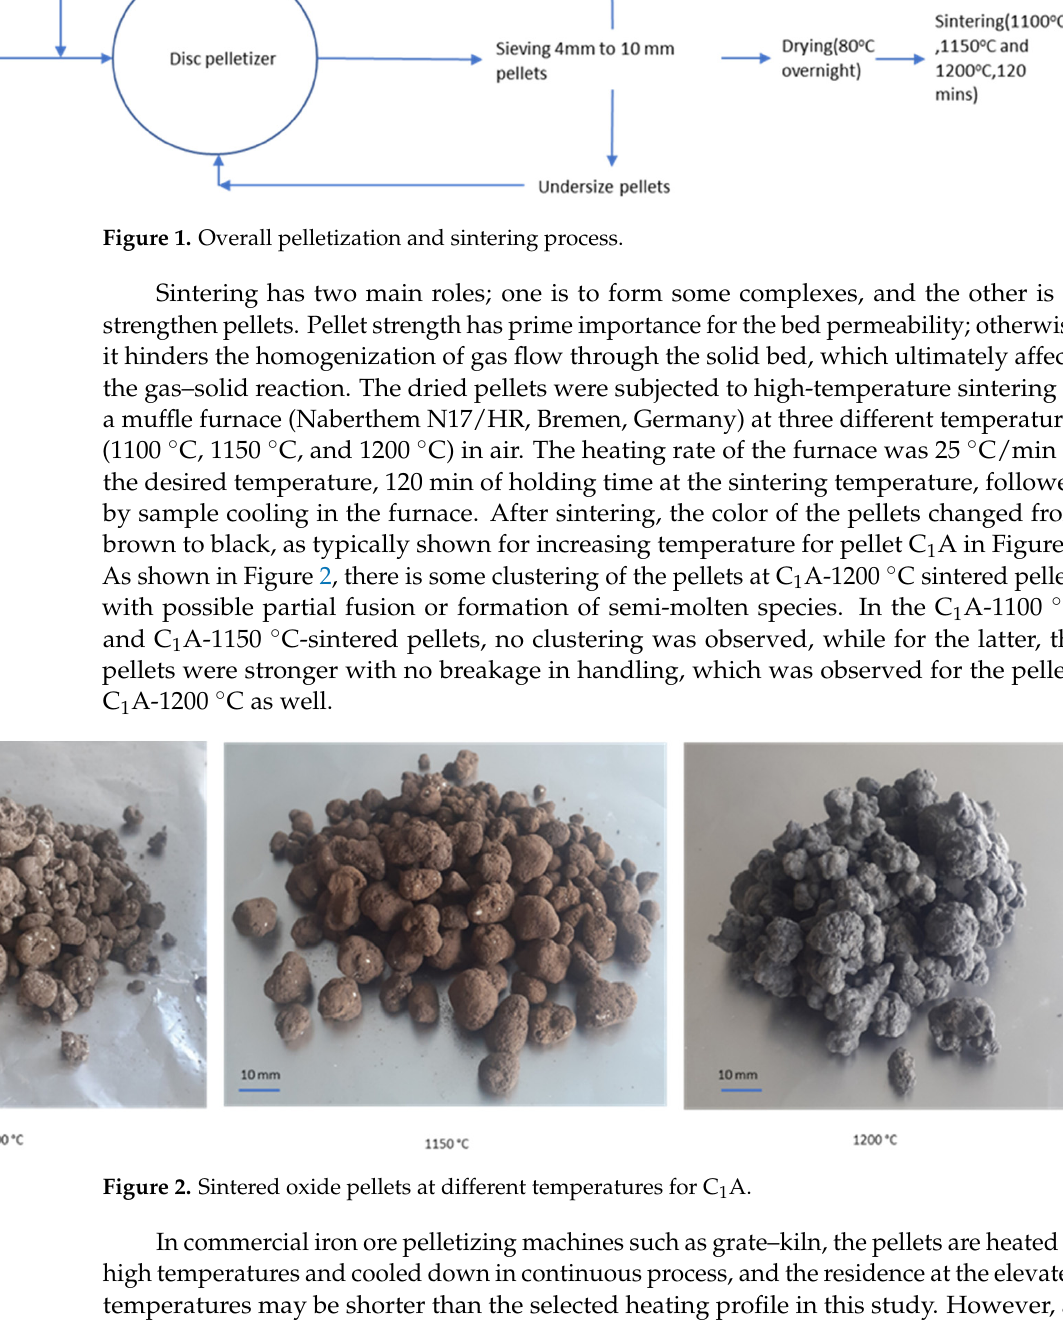
Figure 1. Overall pelletization and sintering process.